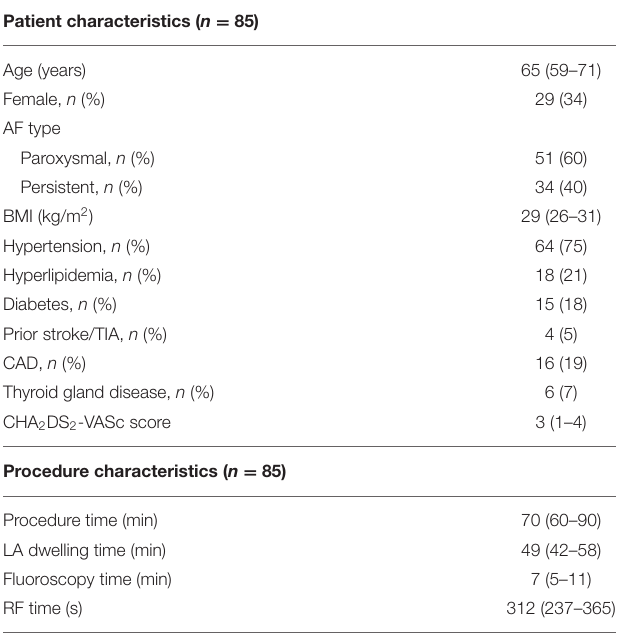
TABLE 1 | Baseline characteristics of the study population and the procedures.